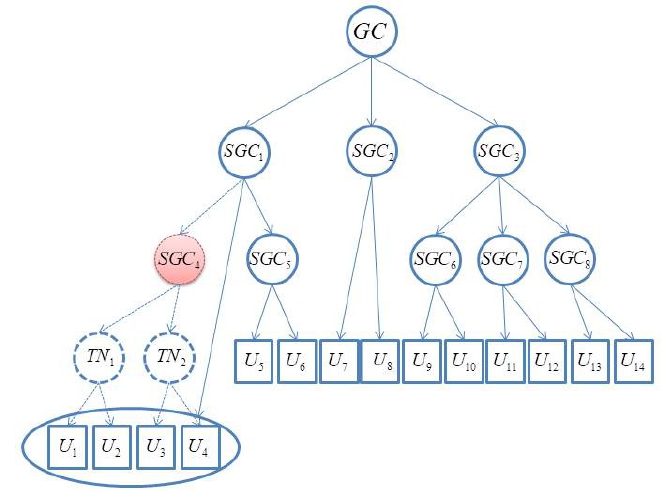
Figure 5. The failure of an